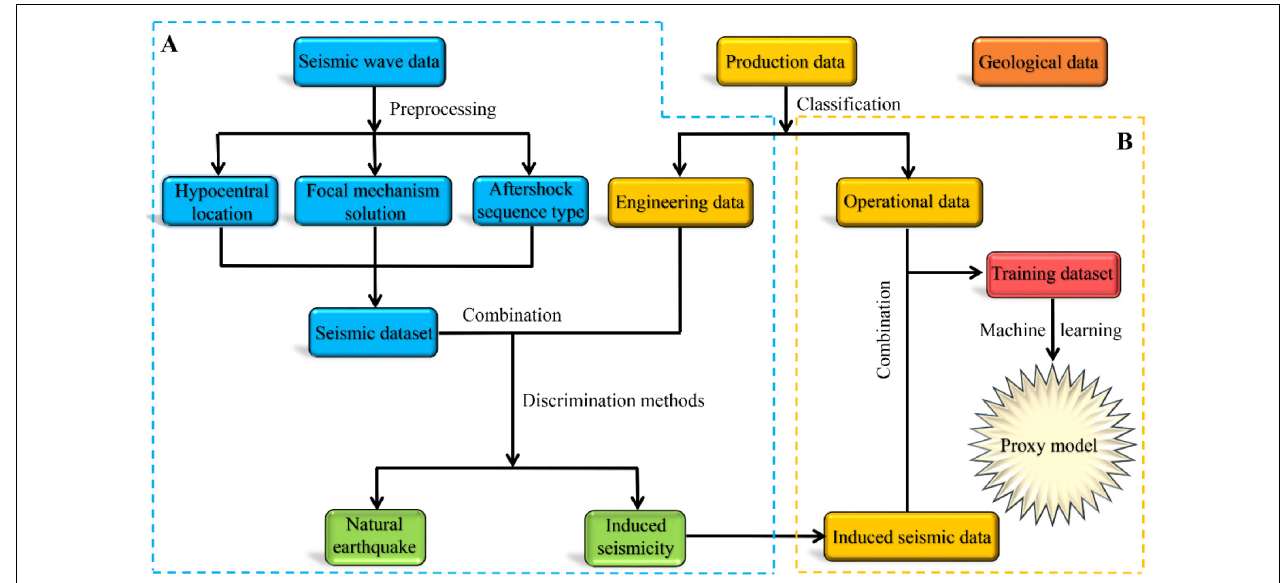
FIGURE 7 | Flowchart for using machine learning methods to improve the adaptive TLS. (A) Identify induced seismicity and (B) Determine the proxy model.